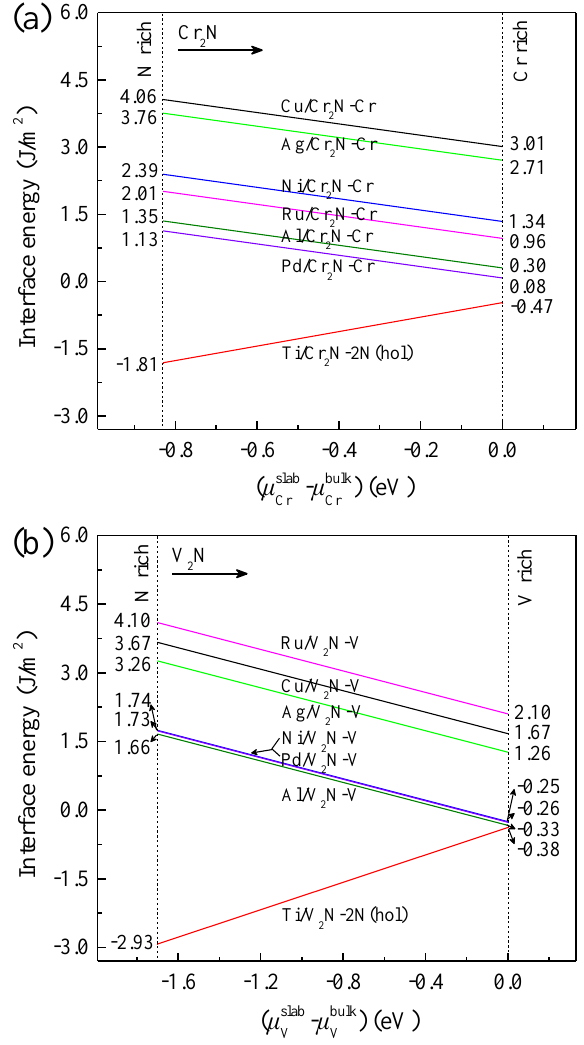
Figure 12. Interfacial energies of the ( a ) M/Cr 2 N and ( b ) M/V 2 N interface models as a function of chromium chemical potential ( μ slab